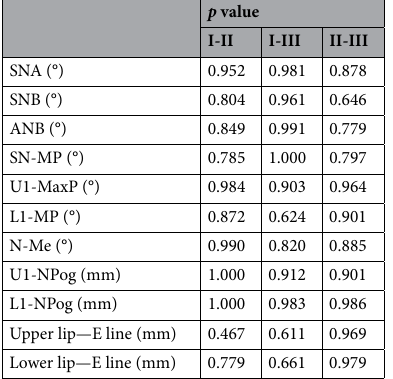
Table 2. Comparisons of landmark detection among the three groups. p value from One-way ANOVA, Tukey’s Post Hoc